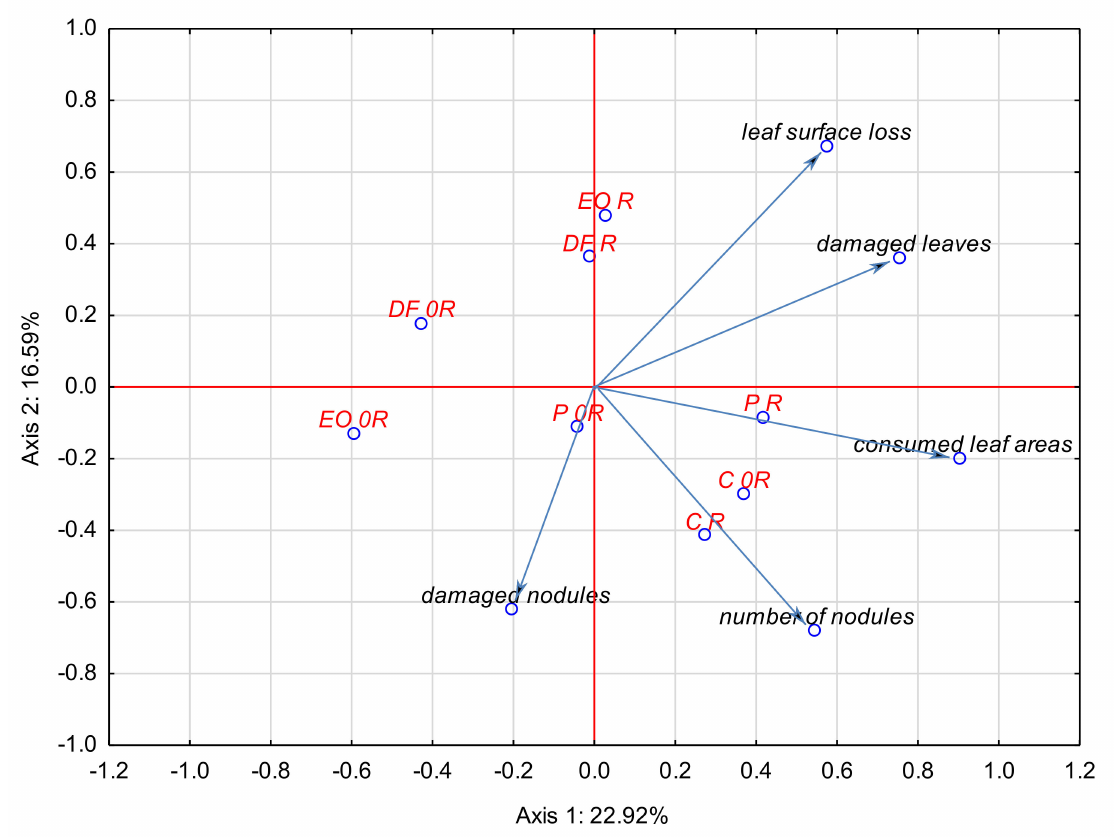
Figure 7. Principal component analysis of Sitona feeding, and soil contamination with PDSs. Symbols as in Table